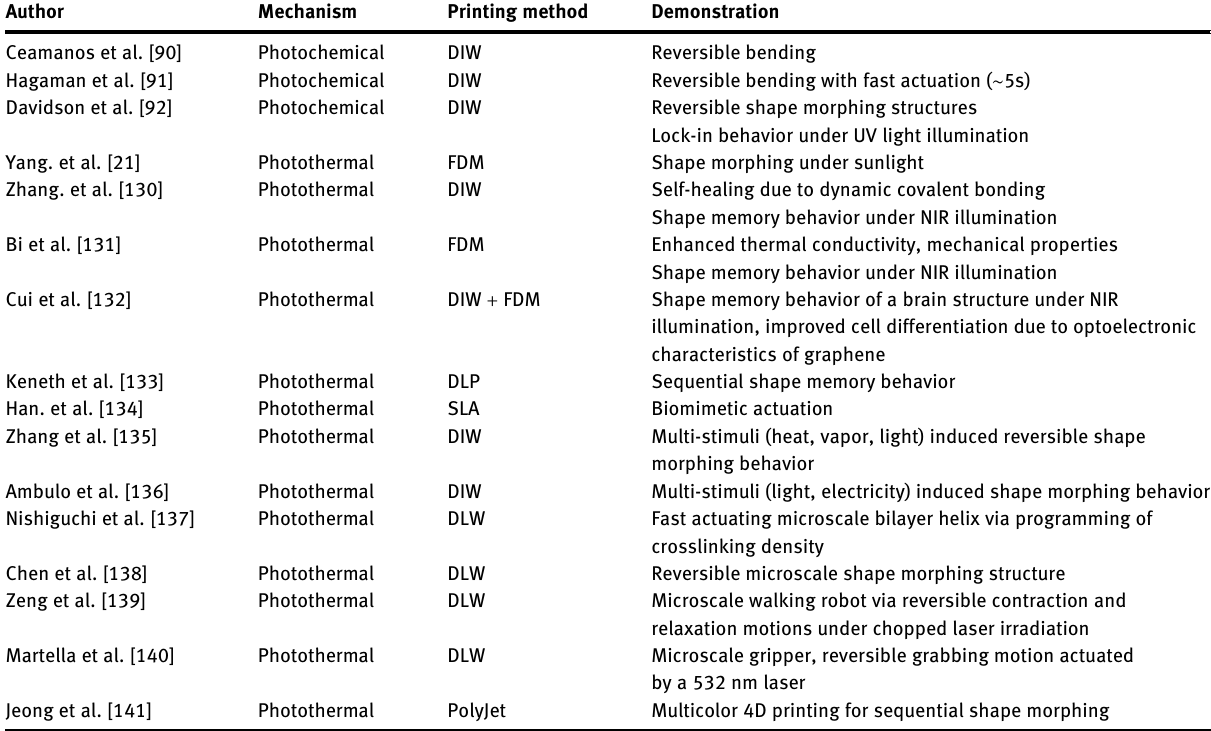
Table  : Light activation of  D-printed